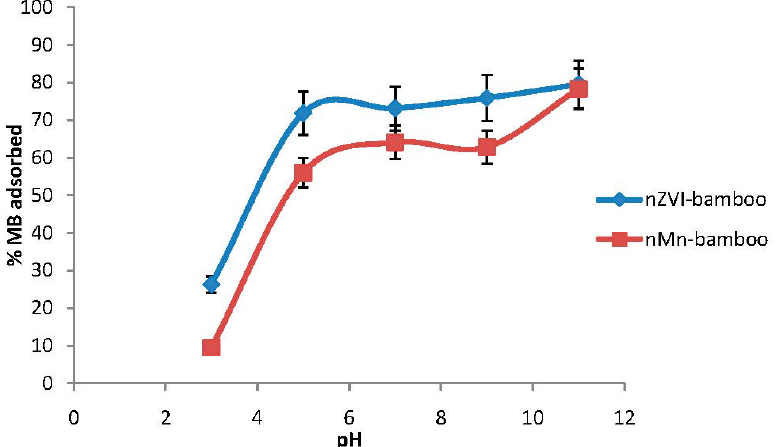
= 140 mg/L, T = 32 ± 2 °C for 2 h at 165 0